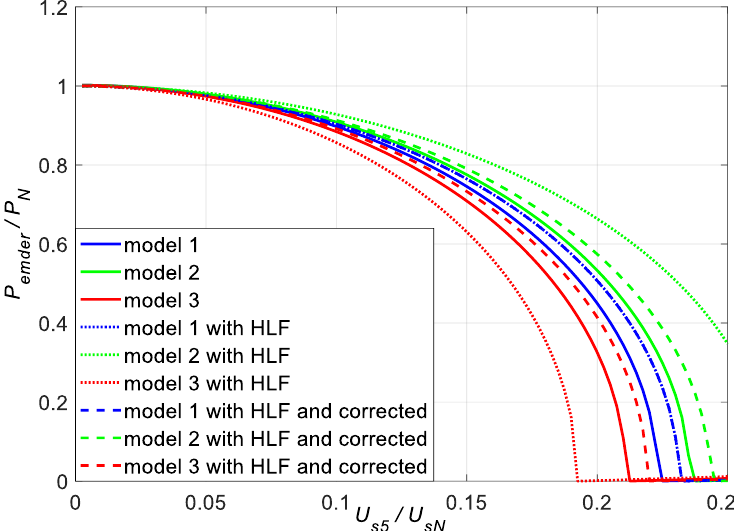
Figure 8. Derating power of the motor as a function of the RMS value of the 5th harmonic of the supply voltage — comparison of curves from Figure 5 with curves obtained based on HLF. Table 3. Comparison of DF values.